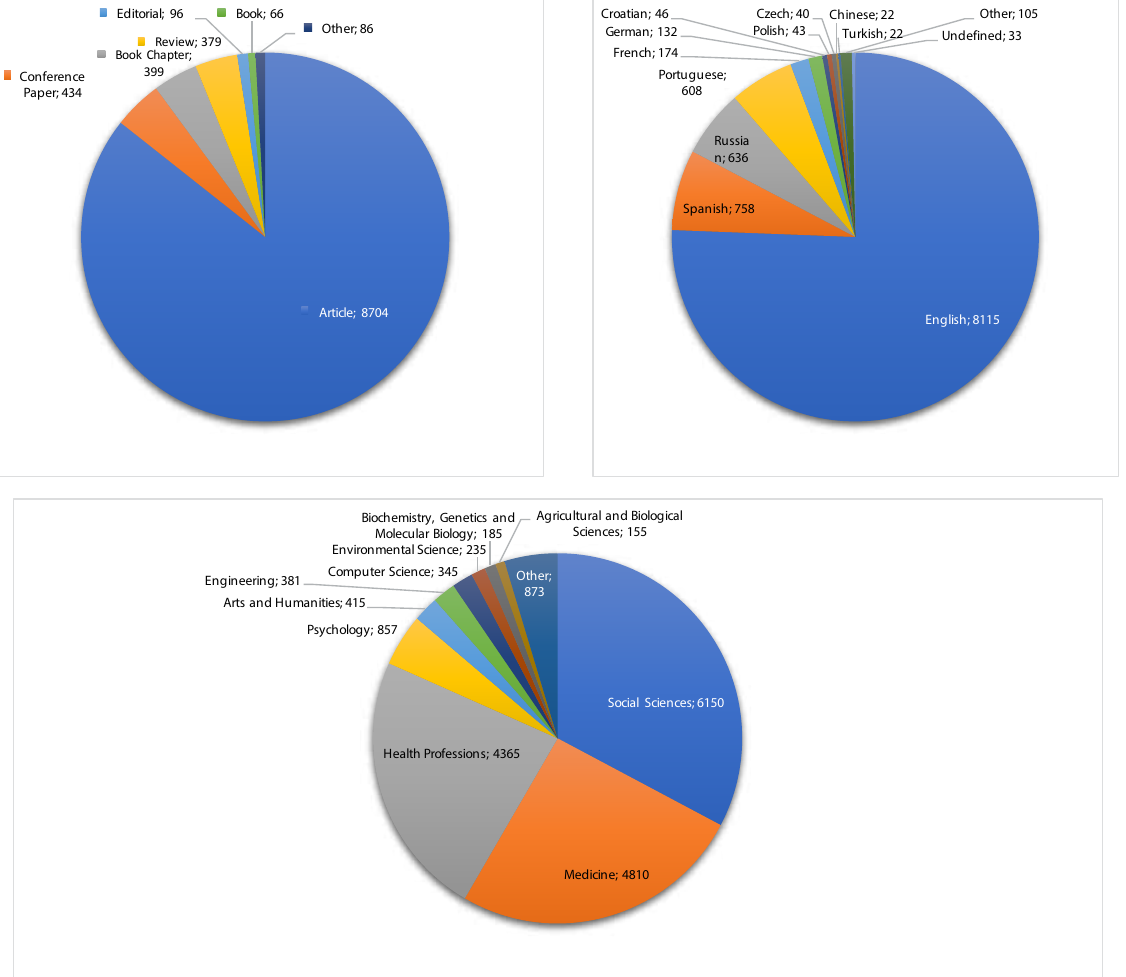
Figure 1. Characteristics of the research sample (by document type, language of publication, subject area): Source: Own study based on data retrieved from Scopus (15 December